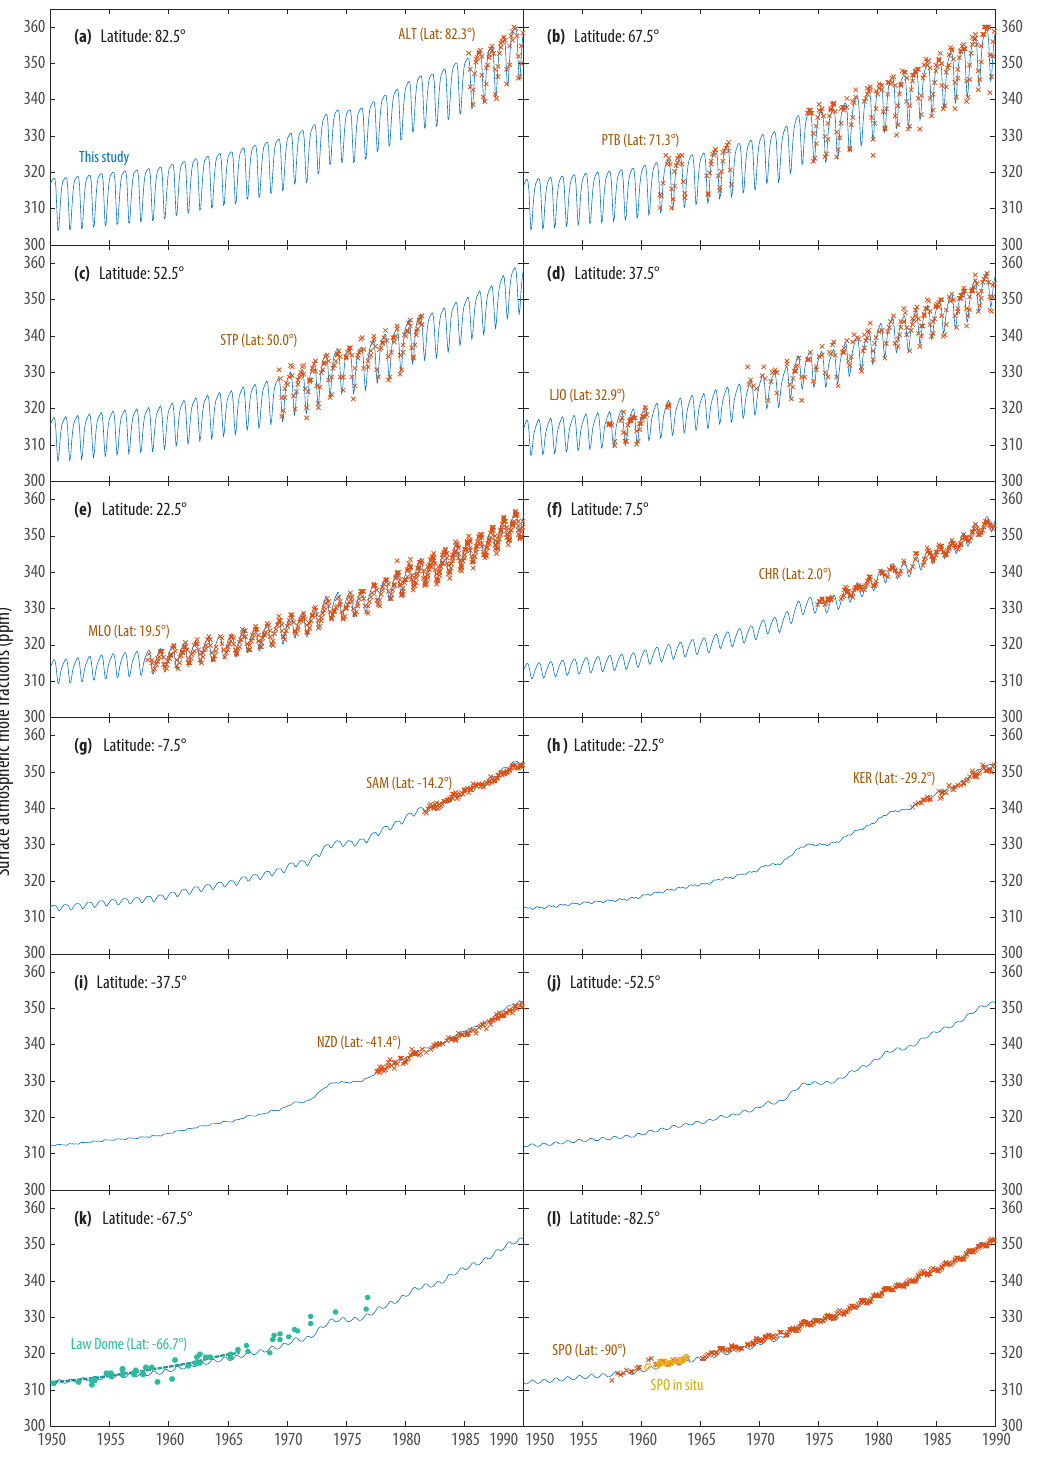
Figure 7. Comparison of 1950–1990 CO 2 concentrations with early Scripps station data (Keeling et al., 2001) for each 15 ◦ latitudinal band. Also, the Law Dome ice record data is shown (k) with our third-degree polynomial smoothing. This study’s monthly CO 2 zonal means were derived from station data from 1984 onwards. Before that, this study used Mauna Loa MLO annual average and smoothed Law Dome data (see Table 1 and Sect. 2). The shown comparison with monthly Scripps station data before 1984 is a qualitative validation of the applied methodology to regress latitudinal gradient and seasonality changes to times before 1984. See